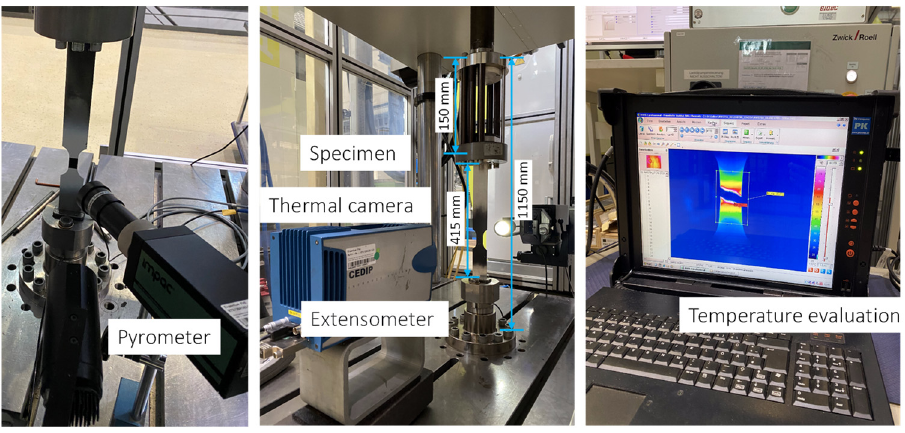
Figure 2. Experiment setup including high-speed thermal camera and pyrometer.